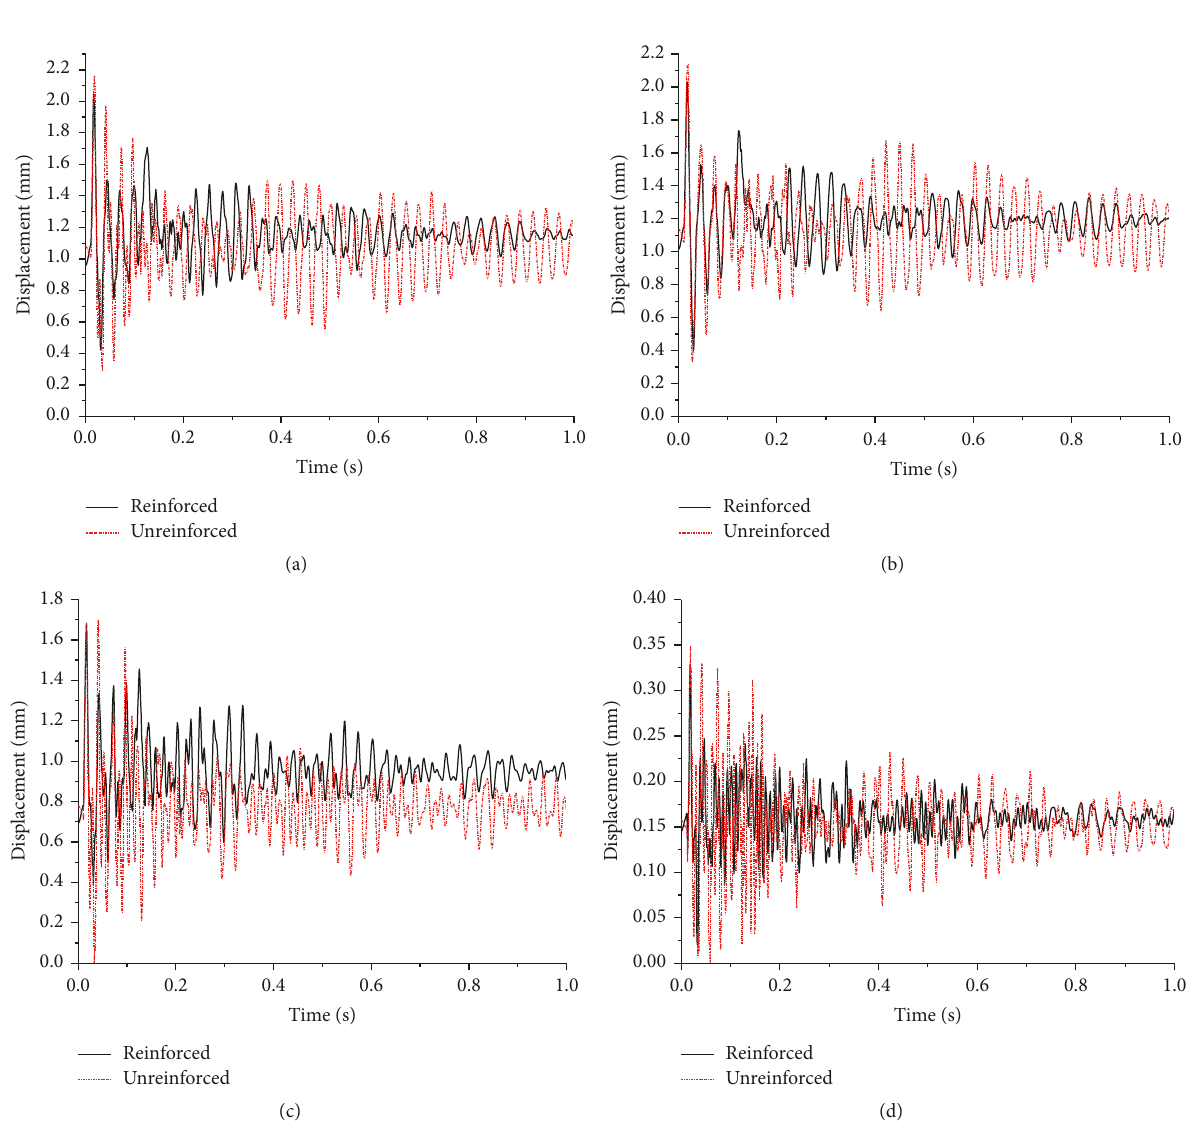
Figure 7: Displacement time history curves of nodes: (a) node 1, (b) node 2, (c) node 3, and (d) node 4.